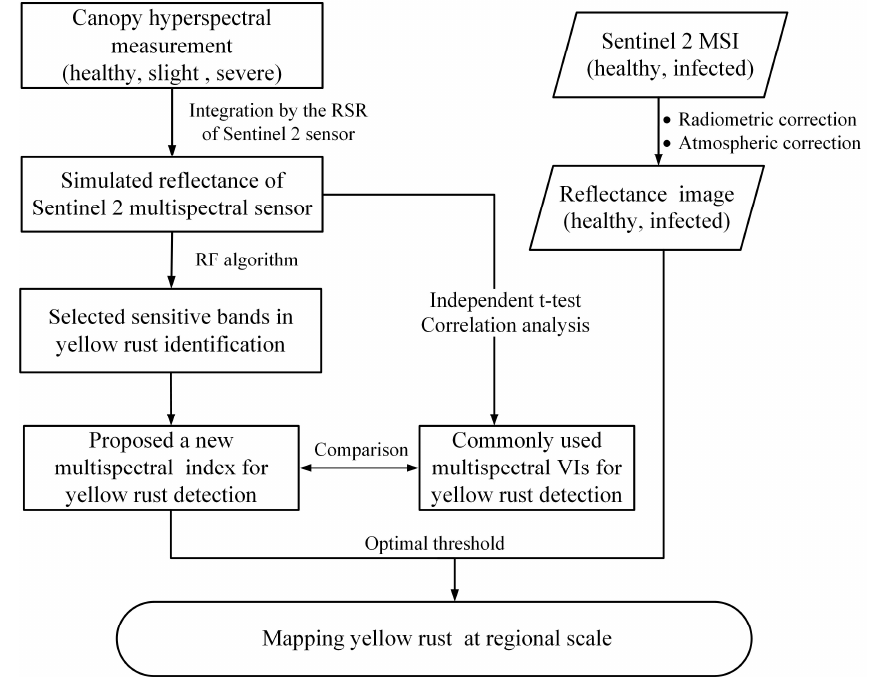
Figure 1. Flowchart of data analysis and processing.